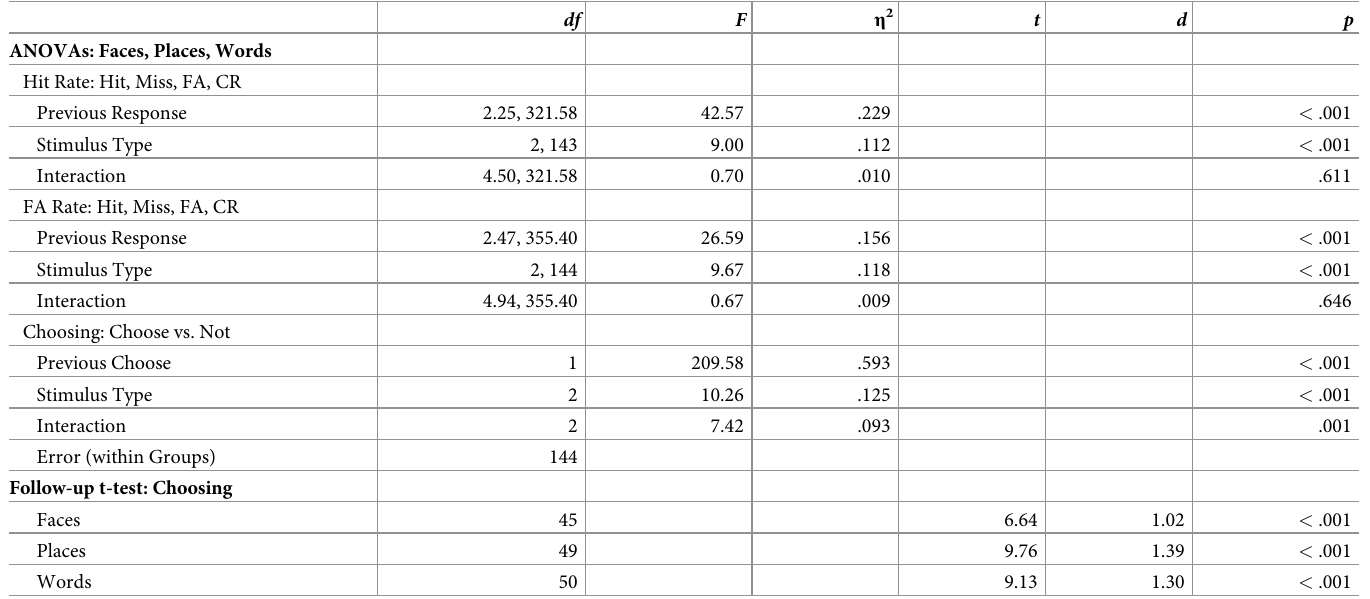
The top panel displays results for mixed ANOVAs on hit rates, false-alarm rates, and choosing rates with previous response as the within-subjects factor and stimulus type (faces, places, and words) as the between-subjects condition. False alarm and correct rejection are abbreviated here as FA and CR, respectively. The bottom panel examines the interaction between stimulus type and choosing rates using paired sample t-tests. Although sequential dependencies of choosing appeared in all three stimuli types, the effect was greatest for places, followed by words, and then faces.